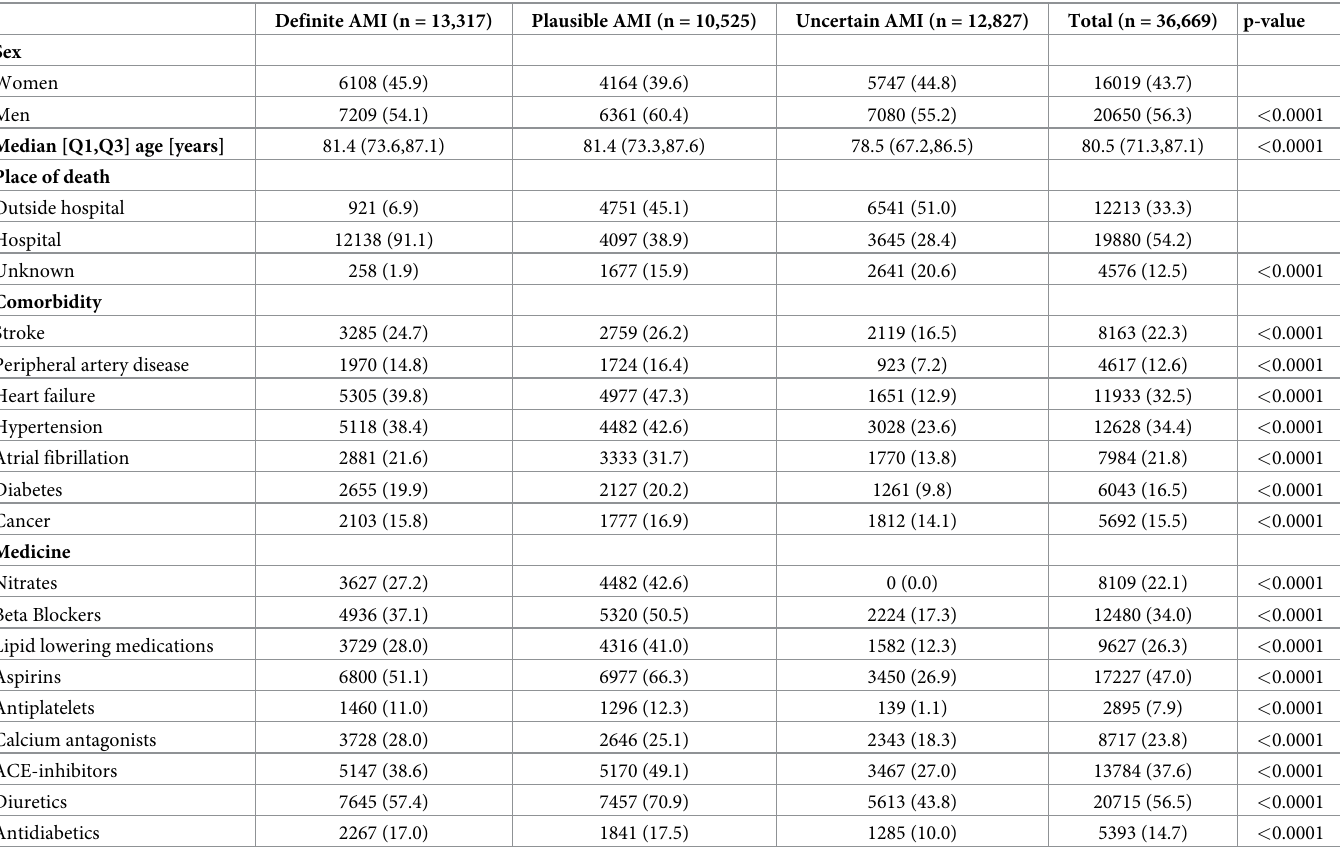
Table 1. Demographic stratification according to diagnostic support for fatal acute myocardial